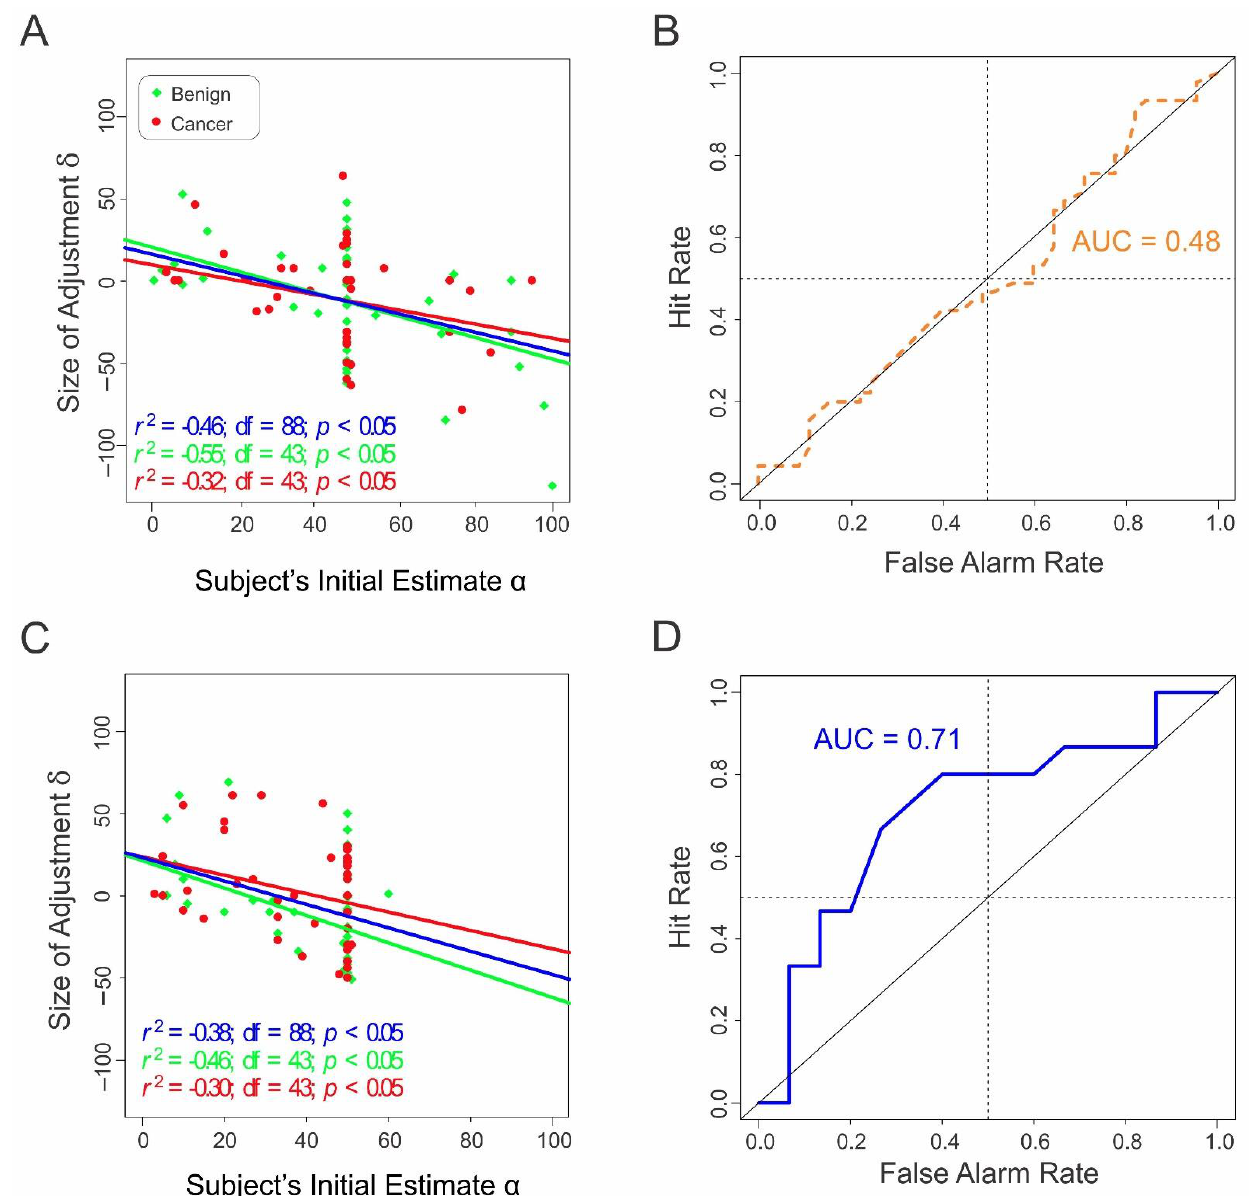
Figure 2. Results from Study 2. ( A ) Radiologists’ final estimates as a function of their initial estimates in the presence of anchoring information. ( B ) ROC analysis of the radiologists’ final estimates in the presence of anchoring information. ( C ) Radiologists’ final estimates as a function of their initial estimates in the absence of anchoring information. ( D ) ROC analysis of the radiologists’ final estimates in the absence of anchoring information.